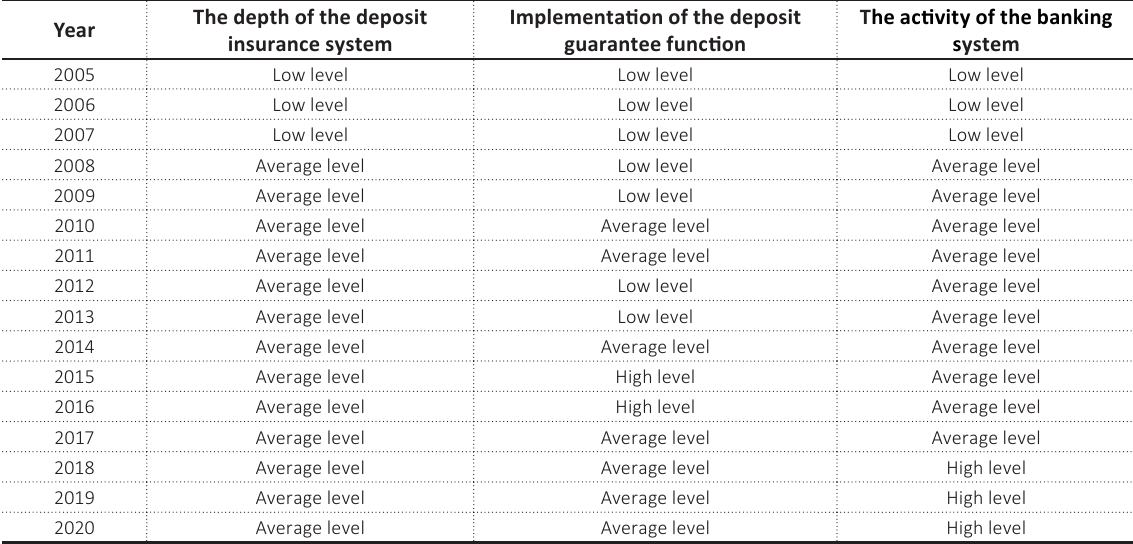
Table 2. Generalized assessment of the depth of the deposit insurance system, the deposit guarantee function implementation, and the activity of Ukraine’s banking system in